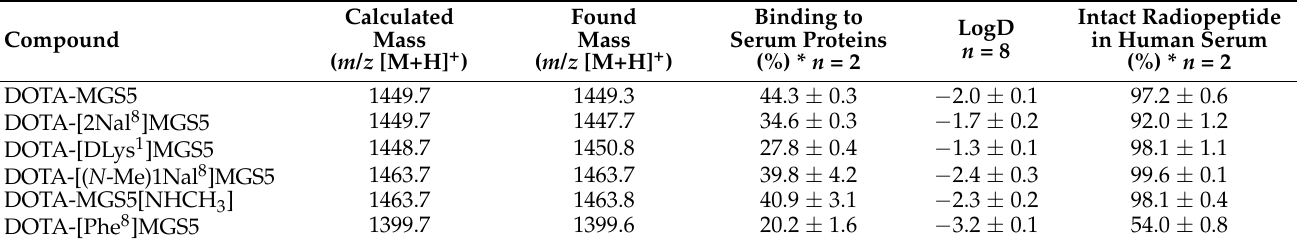
Table 1. Summary of the analytical data of the peptide derivatives, including previously studied DOTA-MGS5